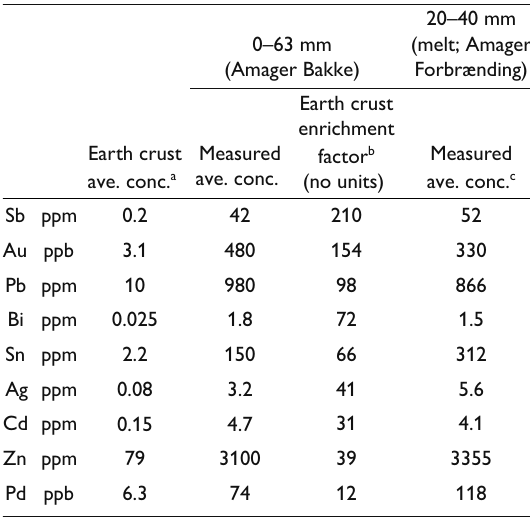
a Obtained from periodictable.com. b Earth crust enrichment factor is the element concentration relative to crustal concentration.